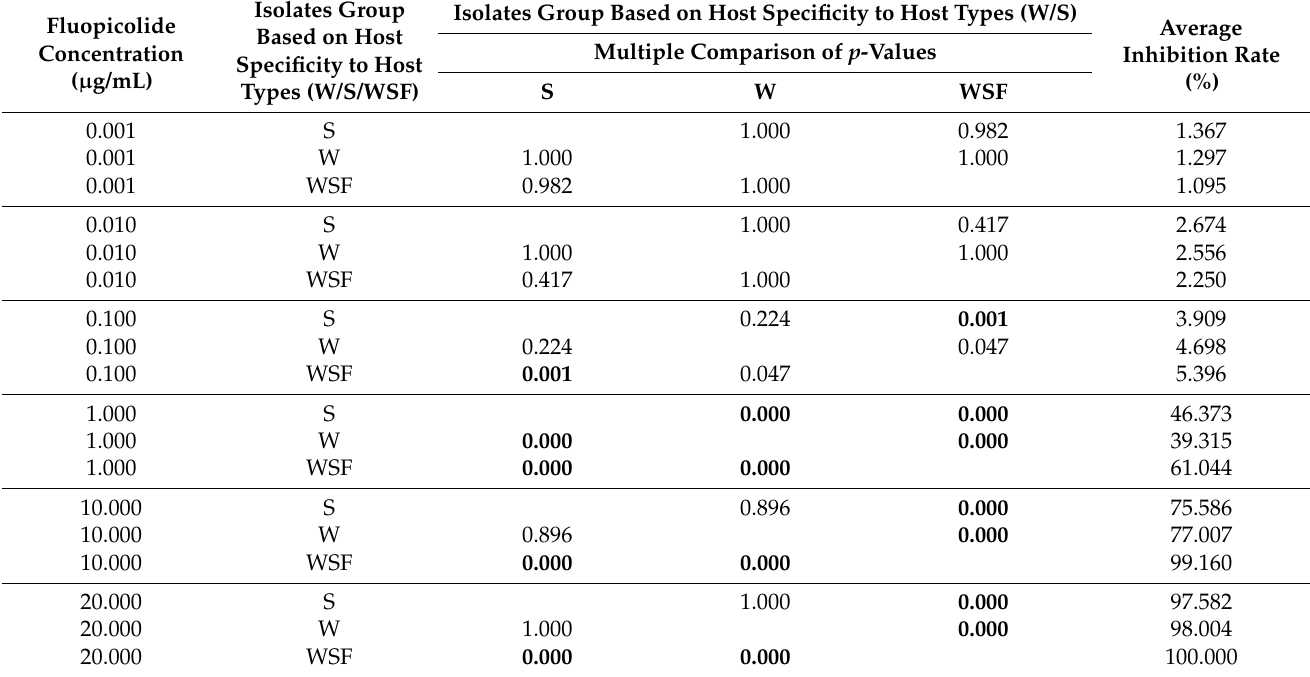
Table 7. Results of a multiple comparison of p -values of the Kruskal–Wallis test of P. cactorum growth inhibition caused by